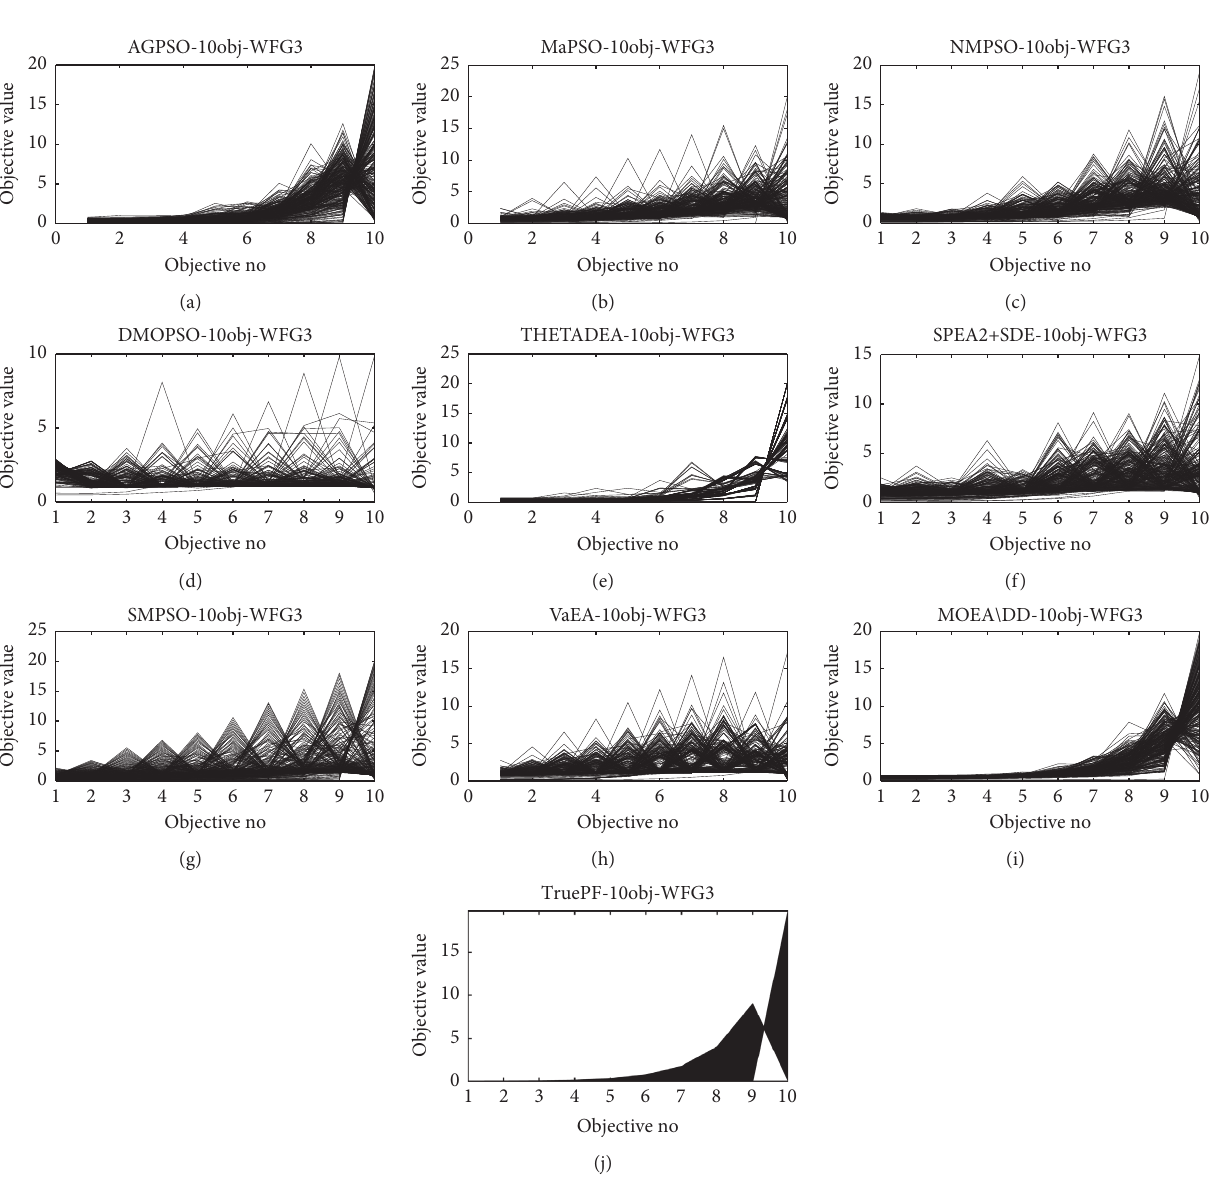
Figure 3: The final solution sets achieved by nine MOEAs/MOPSOs and the true PF on WFG3